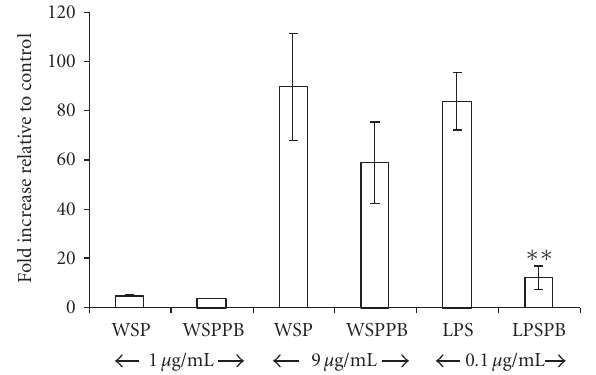
Figure 4: E ff ect of polymyxin B treatment in rWSP-induced TNF mRNA expression in macrophage RAW 264.7 cells. The macrophage cells were incubated with rWSP (WSP; 1 and 9 μ g/mL), polymyxin B-treated rWSP (WSPPB), LPS (LPS; 0.1 μ g/mL), and polymyxin B-treated LPS (LPSPB) for 3 hours. The data represent mean values and standard deviations of fold increase of cytokine transcripts relative to negative control. Significant di ff erences were found between LPS- and LPSPB-treated cells ( P < . 01; indicated by ∗∗